Question: What visual encoding does this figure use to show its data?
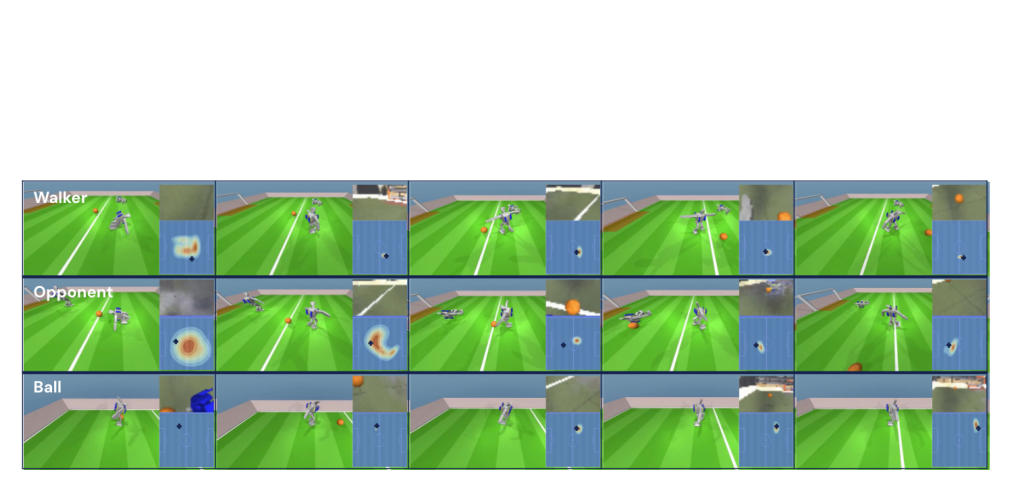
Answer: heatmap